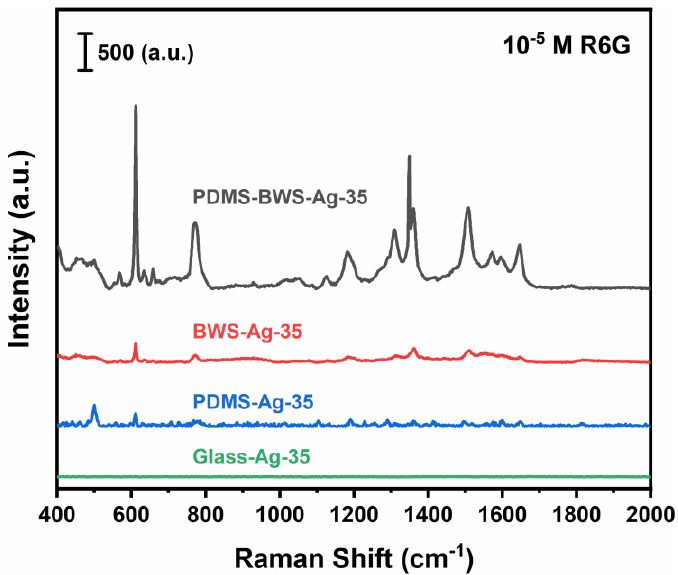
Figure 6. SERS spectra of PDMS-BWS-Ag-35 nm, BWS-Ag-35 nm, pristine PDMS-Ag-35 nm, and glass with R6G (10 − 5 M).